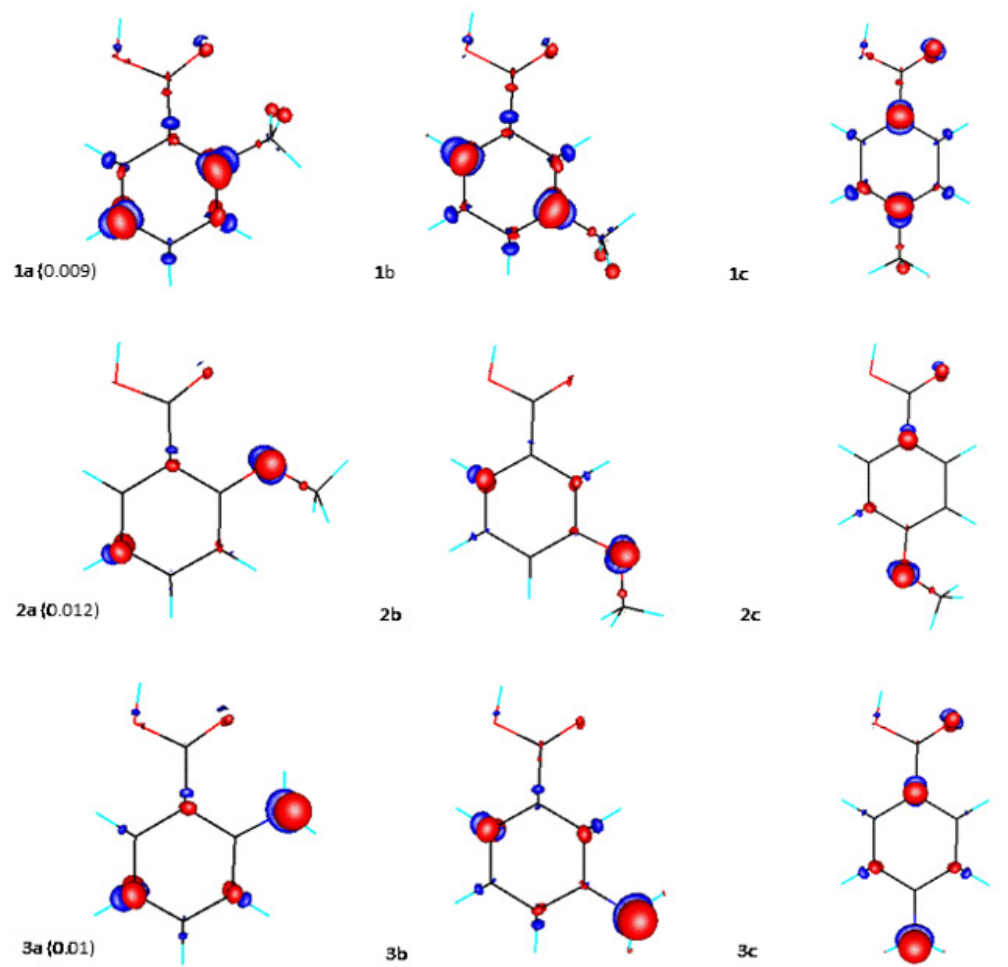
Figure 3. The surface plot of the electrophilic Fukui function f − ( r ) for the benzoic acids with electron-releasing substituent ( 1a – 3c) .